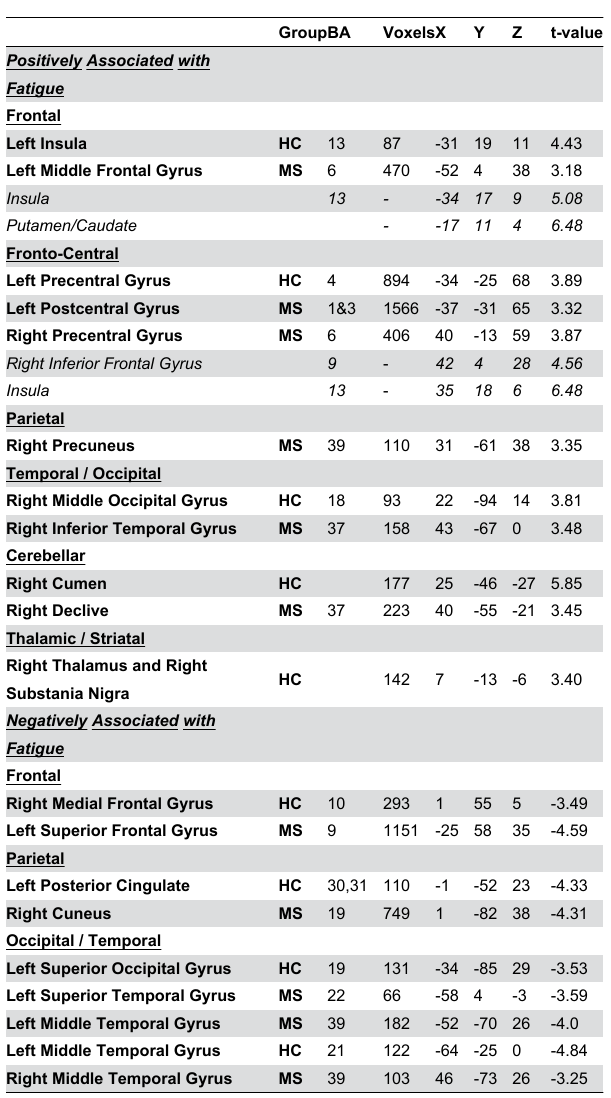
Table 2. BOLD activation during performance of cognitively fatiguing task, associated with self-reported state fatigue (VAS-Fatigue).